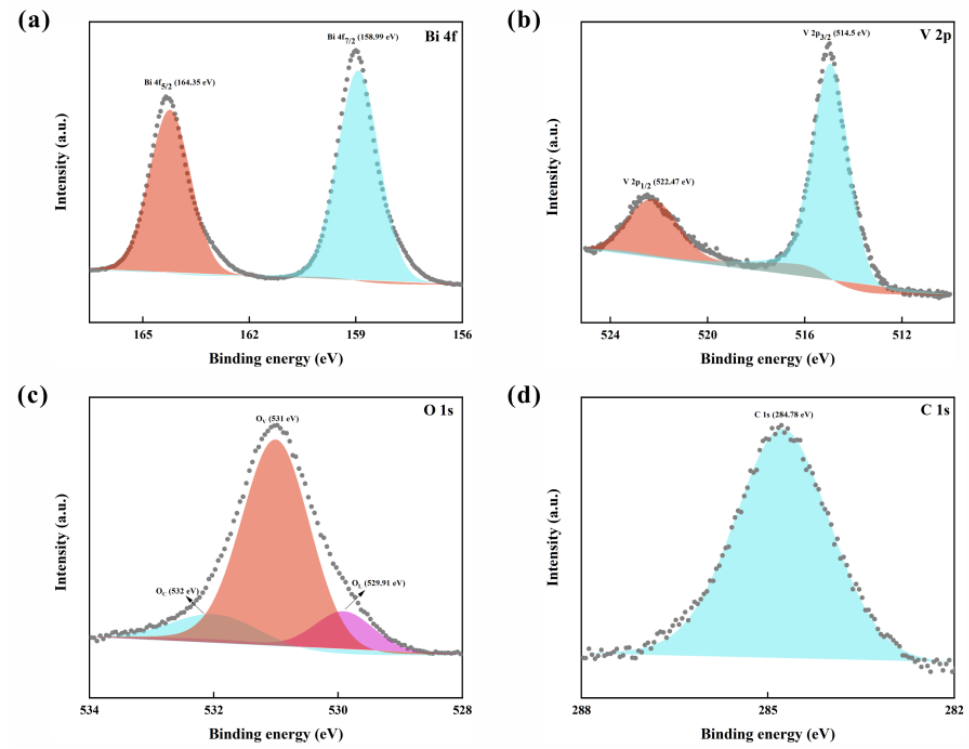
Figure 4. XPS spectra of BVO sample: ( a ) Bi 4f, ( b ) V 2p, ( c ) O 1s, ( d ) C 1s.